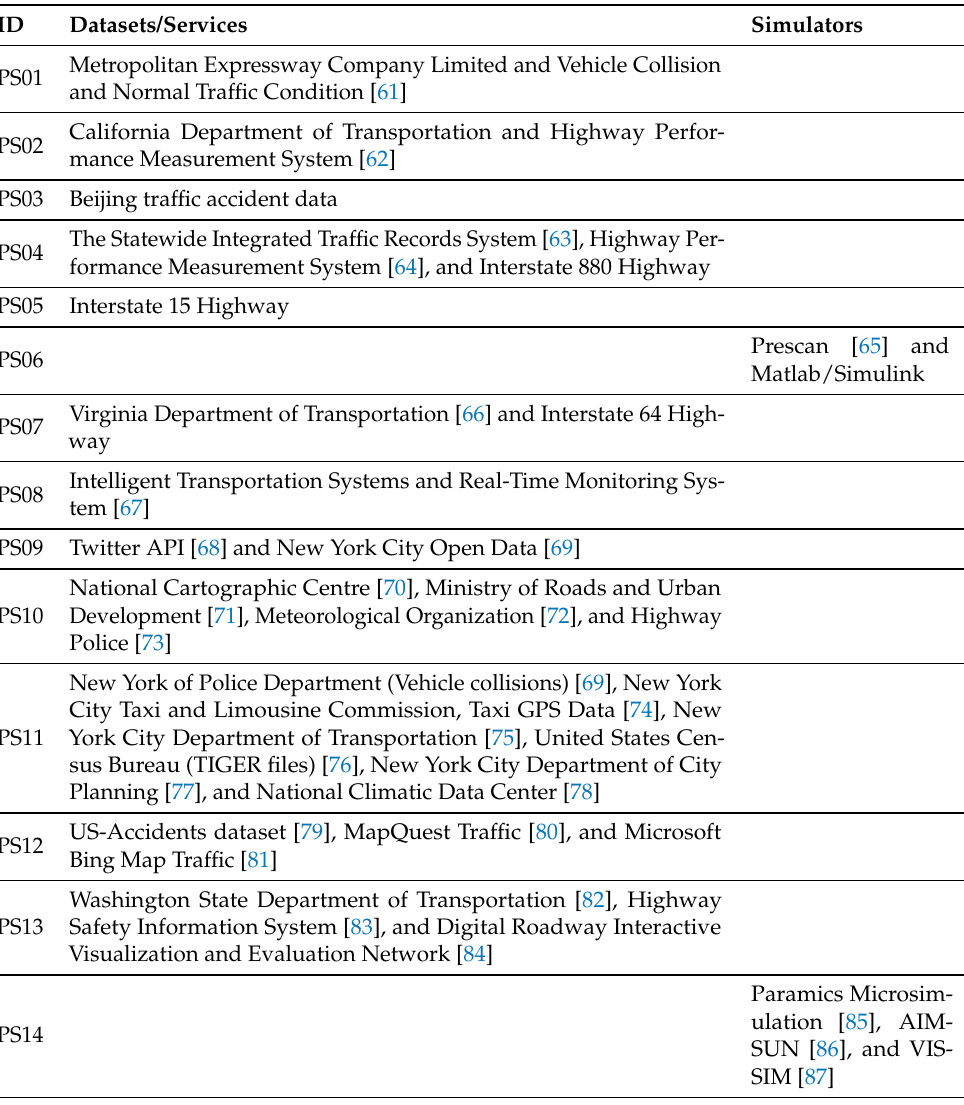
Table A3. Datasets and